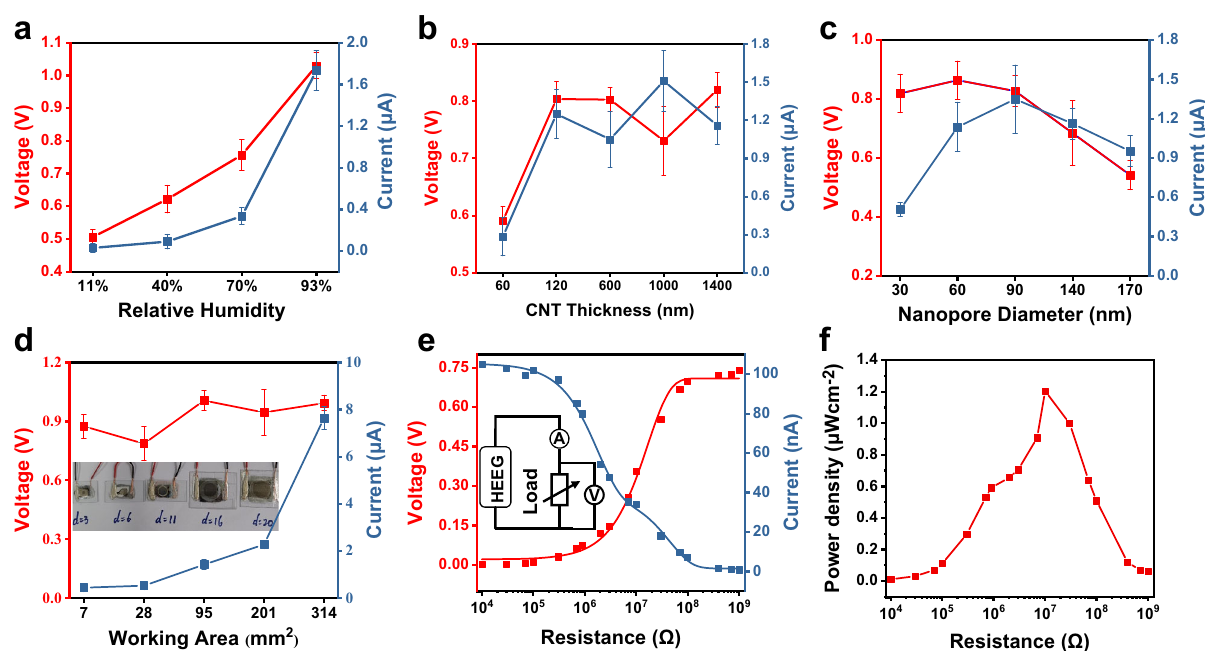
Fig. 2 Electric output performance of HEEG and the corresponding in fl uence factors. In fl uence of relative humidity ( a ), CNT thickness ( b ), nanopore size ( c ) and device working area ( d ) to V OC , I SC, and the inset image in ( d ) is an optical photograph of devices with different working areas. e Current and voltage change with different load resistance for the device which has a working area of 1 mm 2 . The inset is a schematic diagram of the test circuit wiring. f Corresponding output power density changes with different load resistance, and when external resistance is 10 M Ω , the device has the best output performance. The error bars represent standard deviation n = 3 independent